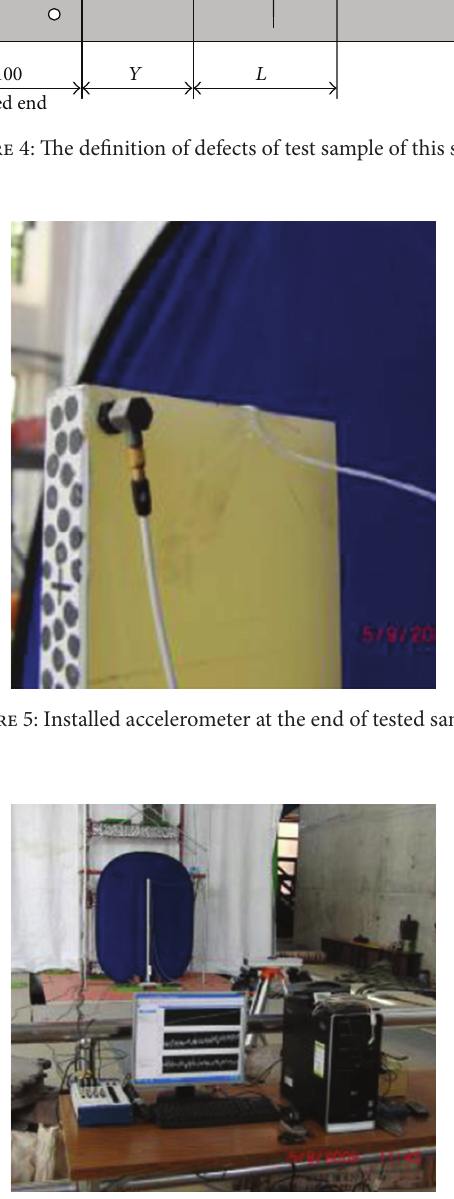
Figure 6: The experimental setup in this study.